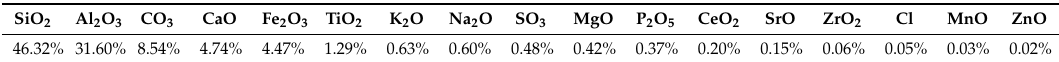
Table 2. Analysis of di ff erent chemical compositions of original fly ash.